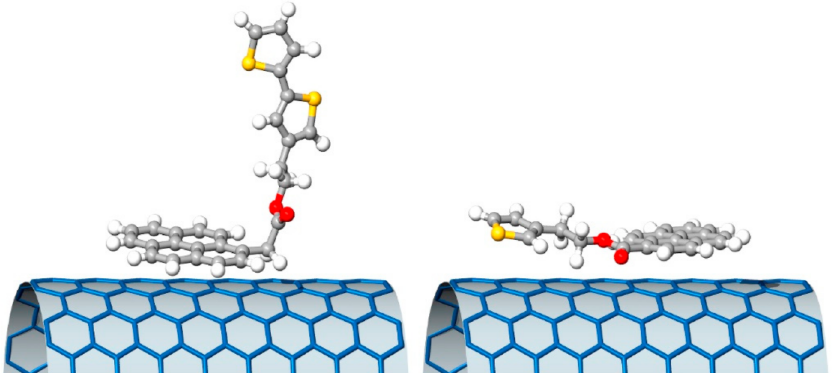
Figure 15. Schematic drawing of the ground state minimum of PyrTh4 ( left ) and PyrTh1 ( right ), and of their possible different approaches to the surface of a carbon nanotube. Reproduced from [92] with the permission of